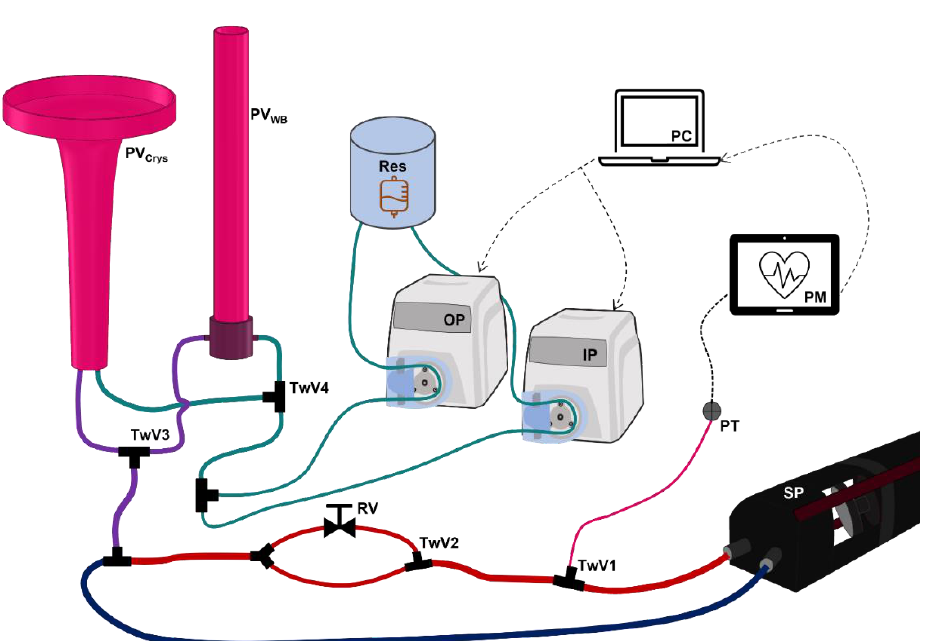
Figure 1. Diagram of Hardware-in-Loop Automated Testbed for Resuscitation Controllers (HATRC) Setup. An overview of the entire testbed is shown with the main circulatory flow loop; arterial and venous sides are colored red and blue, respectively. Pulsatile flow is generated by a ViVitro Labs SuperPump (SP). Then, arterial pressure is measured by a pressure transducer (PT) through fluidic connection at a three-way valve (TwV1). Arterial waveform data are displayed with a patient monitor (PM) and recorded in real-time by a computer (PC) running the hemorrhage scenarios and infusion controller. An instantaneous increase in pressure can be applied using TwV2 to direct the flow through a regulating valve (RV). Static pressure is supplied to the loop via the purple fluidic line from either whole blood (PV WB ) or crystalloid (PV Crys ) PhysioVessels based on the position of TwV3. Infusion (IP) and outflow (OP) peristaltic pumps are supplied with water from an external reservoir (Res) and are connected via the teal fluidic line to add or remove volume from the appropriate PhysioVessel based on the position of TwV4. Both peristaltic pumps are fully controlled by an algorithm running on the PC.